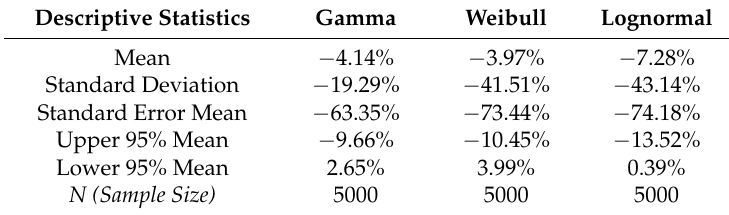
Table 10. Comparison of bias between empirical data GLMs and simulation data GLMs.